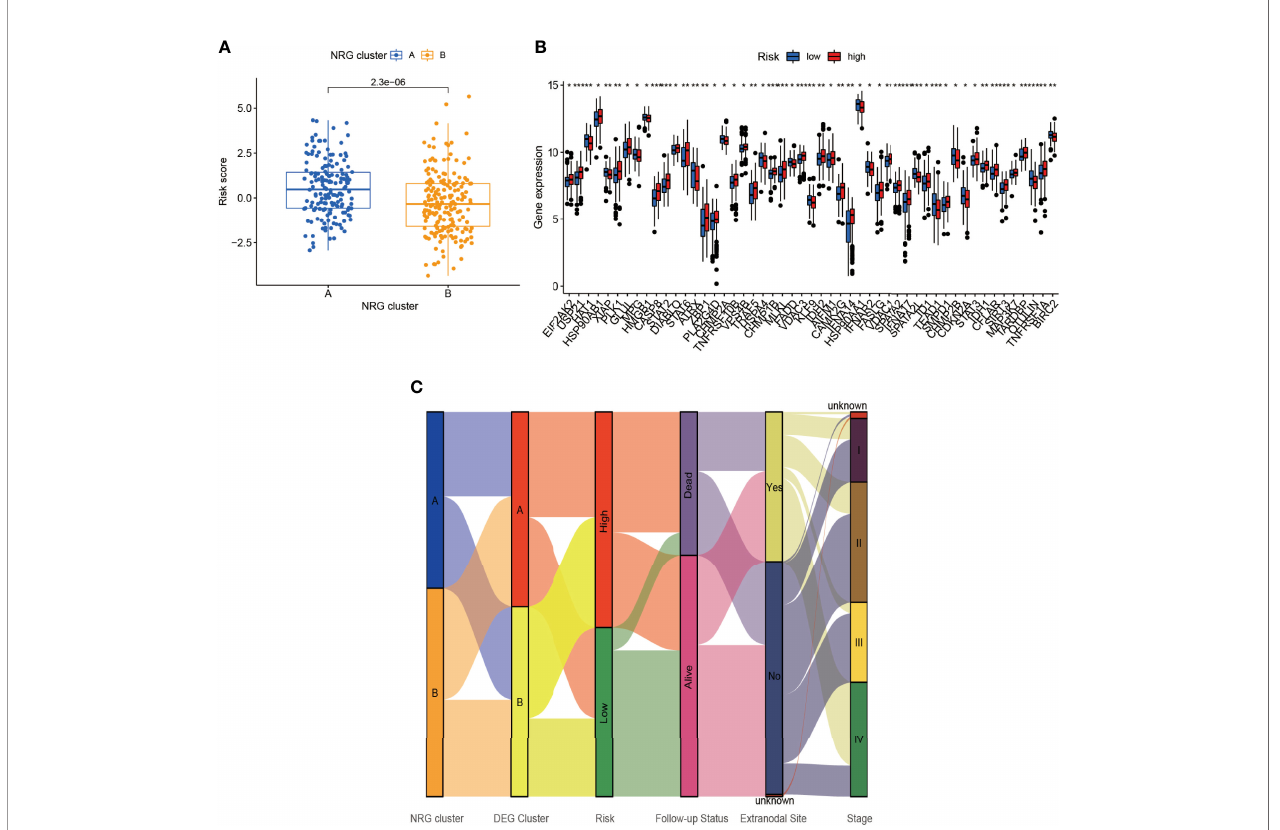
FIGURE 6 | Connection of risk score and NRG clusters. (A) The relationship of risk score and NRG clusters ( p = 2.3×10 -6 ). (B) The differential NRGs between the low- and high-risk group. (C) Sankey diagram including NRG clusters, DEG clusters, risk score, follow-up status, extranodal site, and stage. * p < 0.05, ** p < 0.01, *** p <